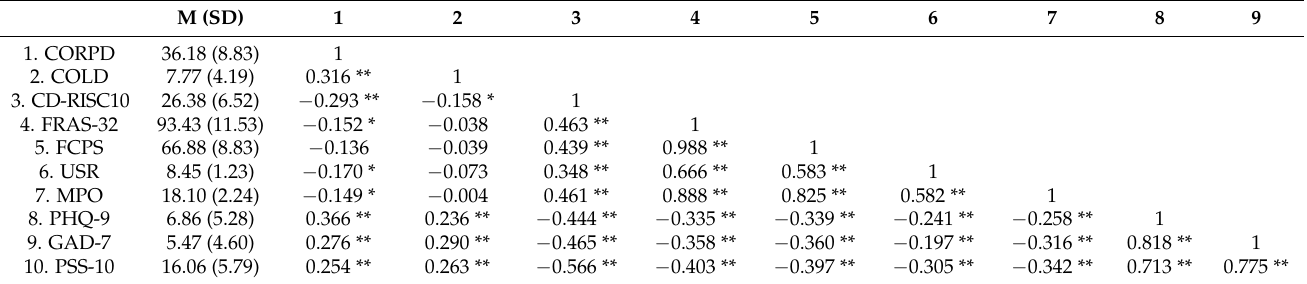
Table 2. Correlations for study variables.